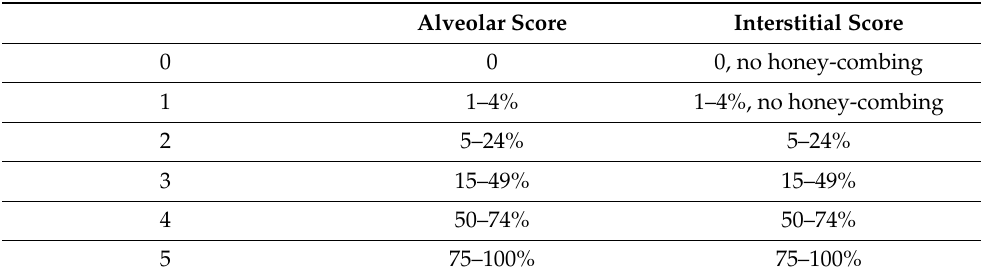
Table 1. HRCT scoring system in